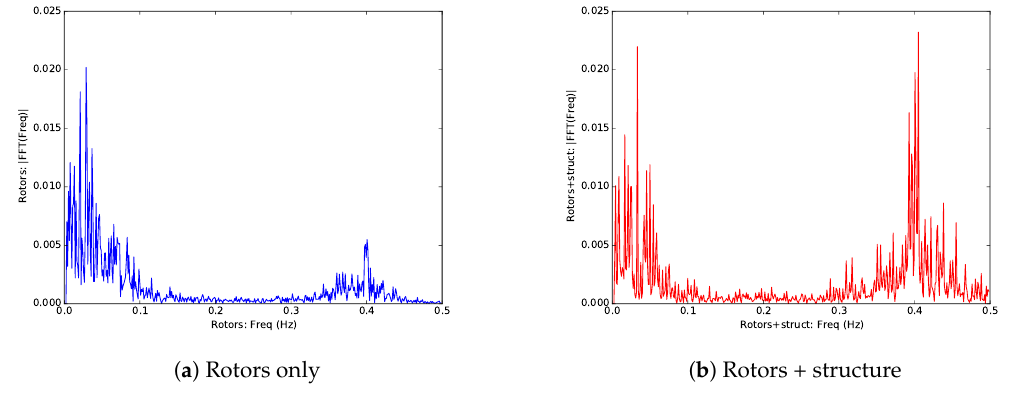
Figure 16. Resolved turbulence spectra at 1D downstream from the top of the T1 rotor, for ( a ) the rotors case and ( b ) rotors + structure. Both cases show a second peak at 0.4 Hz, with the peak four-times higher in the rotors + structure case.